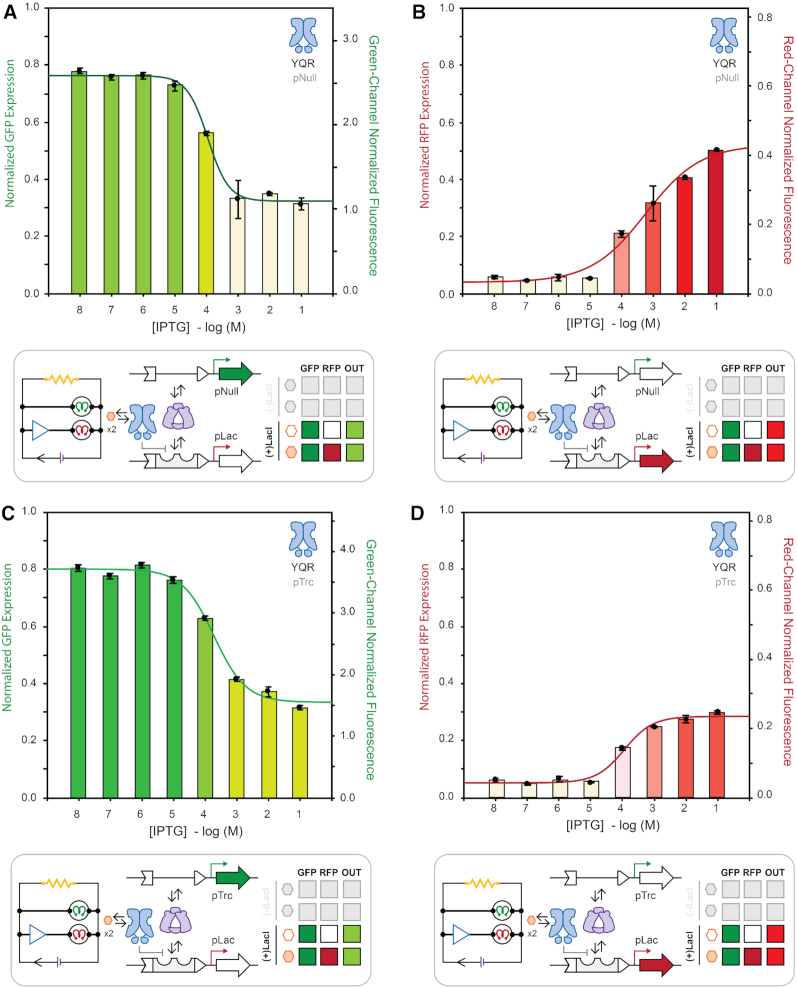
Inducer titration isotherms comparing constitutive GFP and inducible RFP coupled-expression at steady-state (t = 20 h) under wild-type LacI regulation. GFP (A) and RFP (B) expression for a reported plasmid delivering the promoters pNull GFP and pLac RFP. GFP (C) and RFP (D) expression for a reported plasmid delivering the promoters pTrc GFP and pLac RFP. Fluorescence from green (λex = 485 nm, λem = 510 nm, gain = 400) and red (λex = 585 nm, λem = 610 nm, gain = 400) channels normalized by culture density (λabs = 600 nm), and reported as the fraction of total potential fluorescence as well as ×104 relative fluorescence units, on left and right vertical axes, respectively.